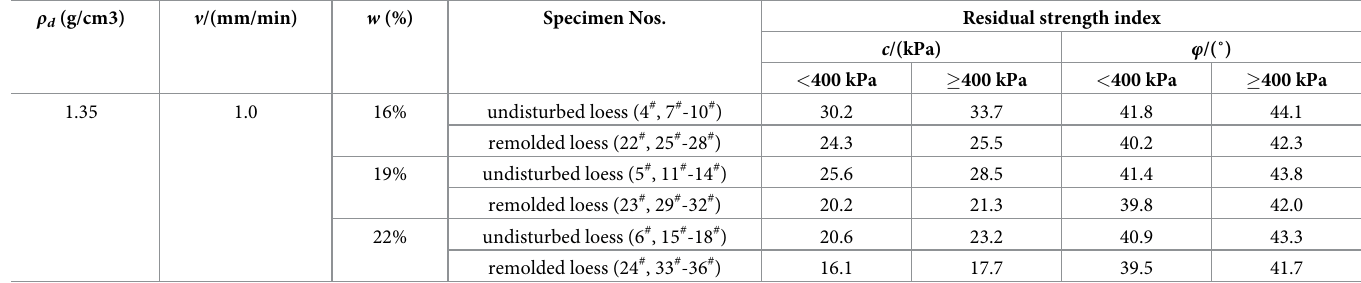
Table 3. Residual strength index of 4 # -18 # undisturbed and 22 # - 36 # remolded loess specimens. ρ d (g/cm3) v